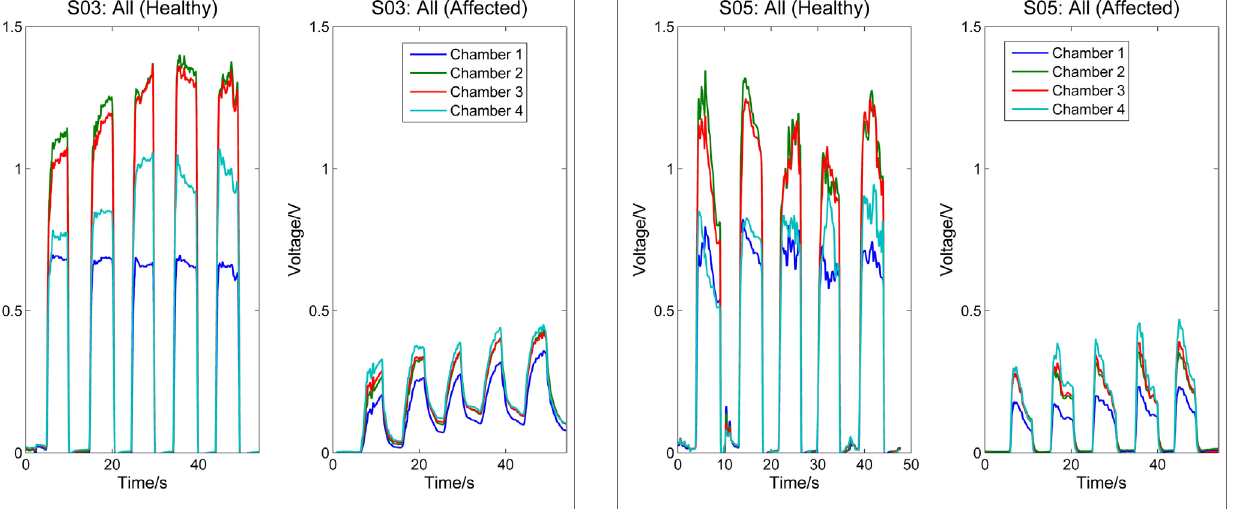
FigUre 6 | comparison between healthy and affected hands of s05 (grasp) . Signals recorded from the four chambers of the finger sensor when S05 compressed it with all fingers (both healthy and